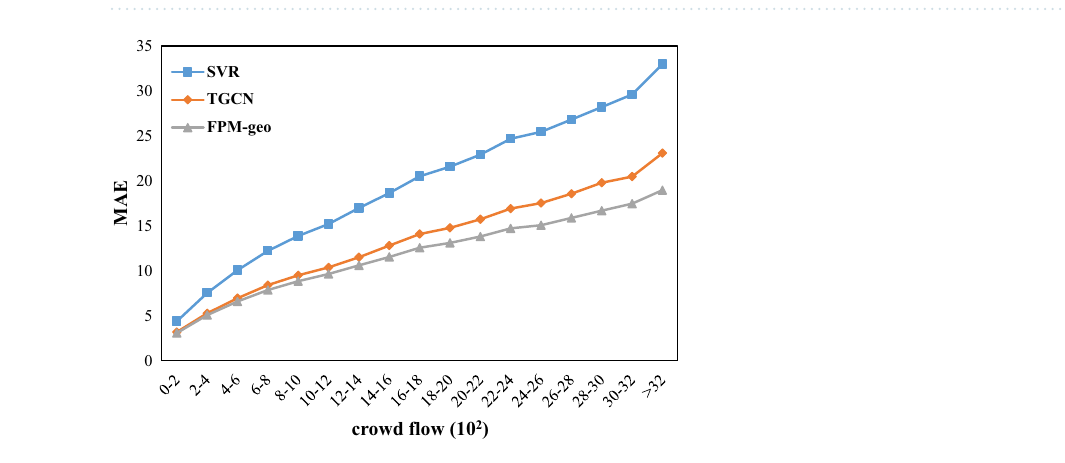
Figure 12. MAE distributions based on the number of people in the grid.